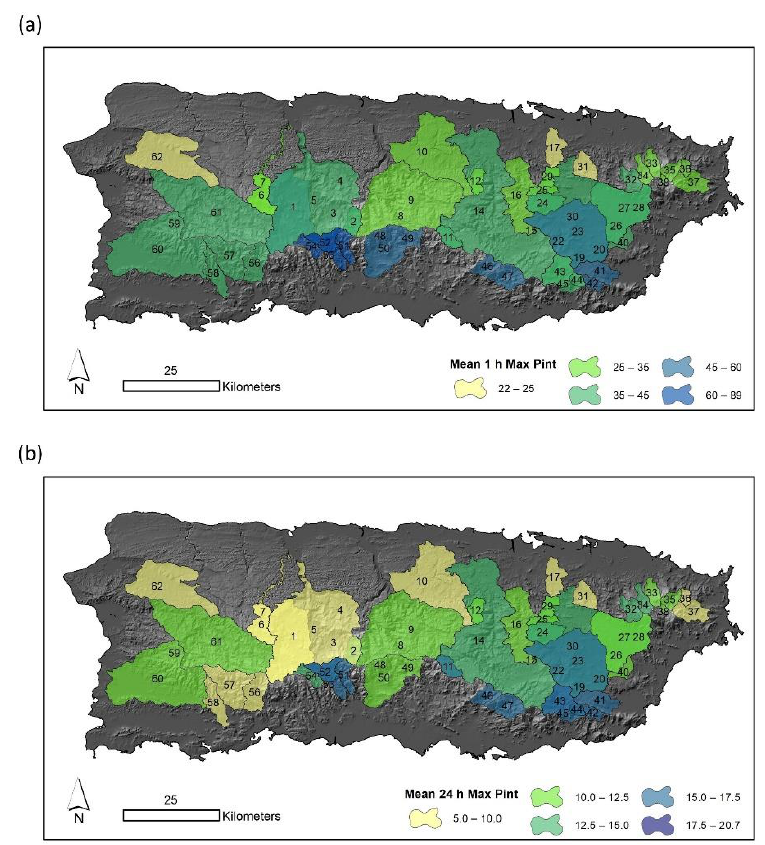
Figure 6. Watershed-by-watershed rainfall characteristics during Hurricane Fiona. ( a ) Mean 1 h rain intensities. ( b ) Mean 24 h rain intensities.